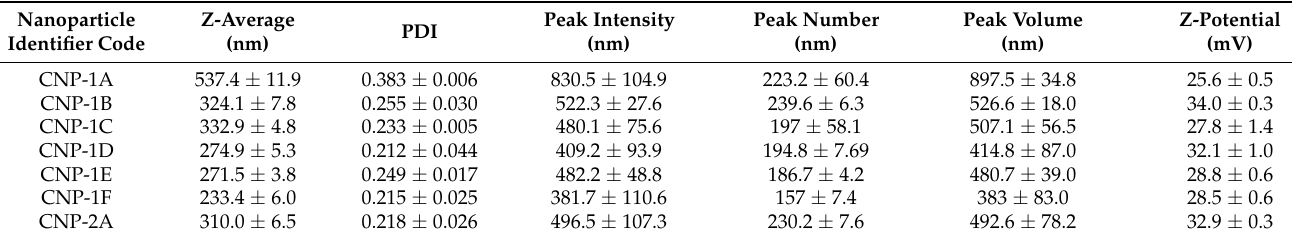
Table 2. Particle size distribution and Z-potential of CNPs by DLS.